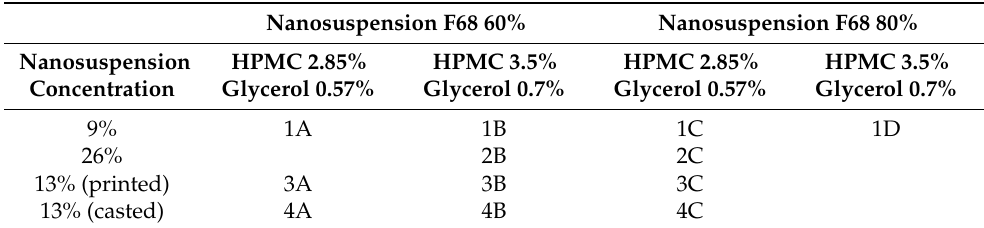
Table 3. Composition of the different tested film samples for printing (films 1A–3C). As a reference sample, film casting was performed with a 13% nanosuspension concentration (films